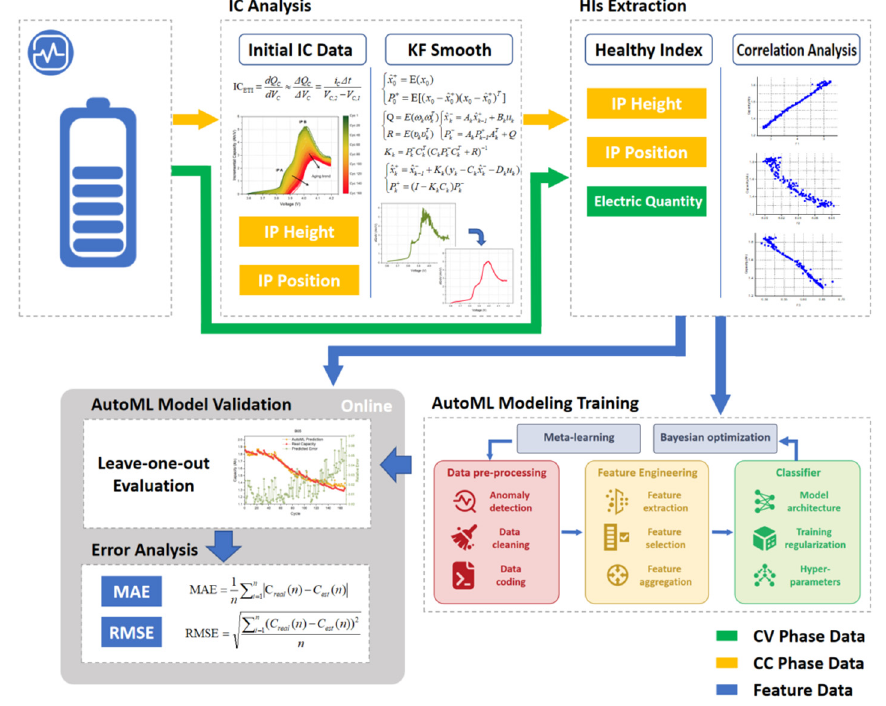
Figure 8. Framework of RUL prediction based AutoML.